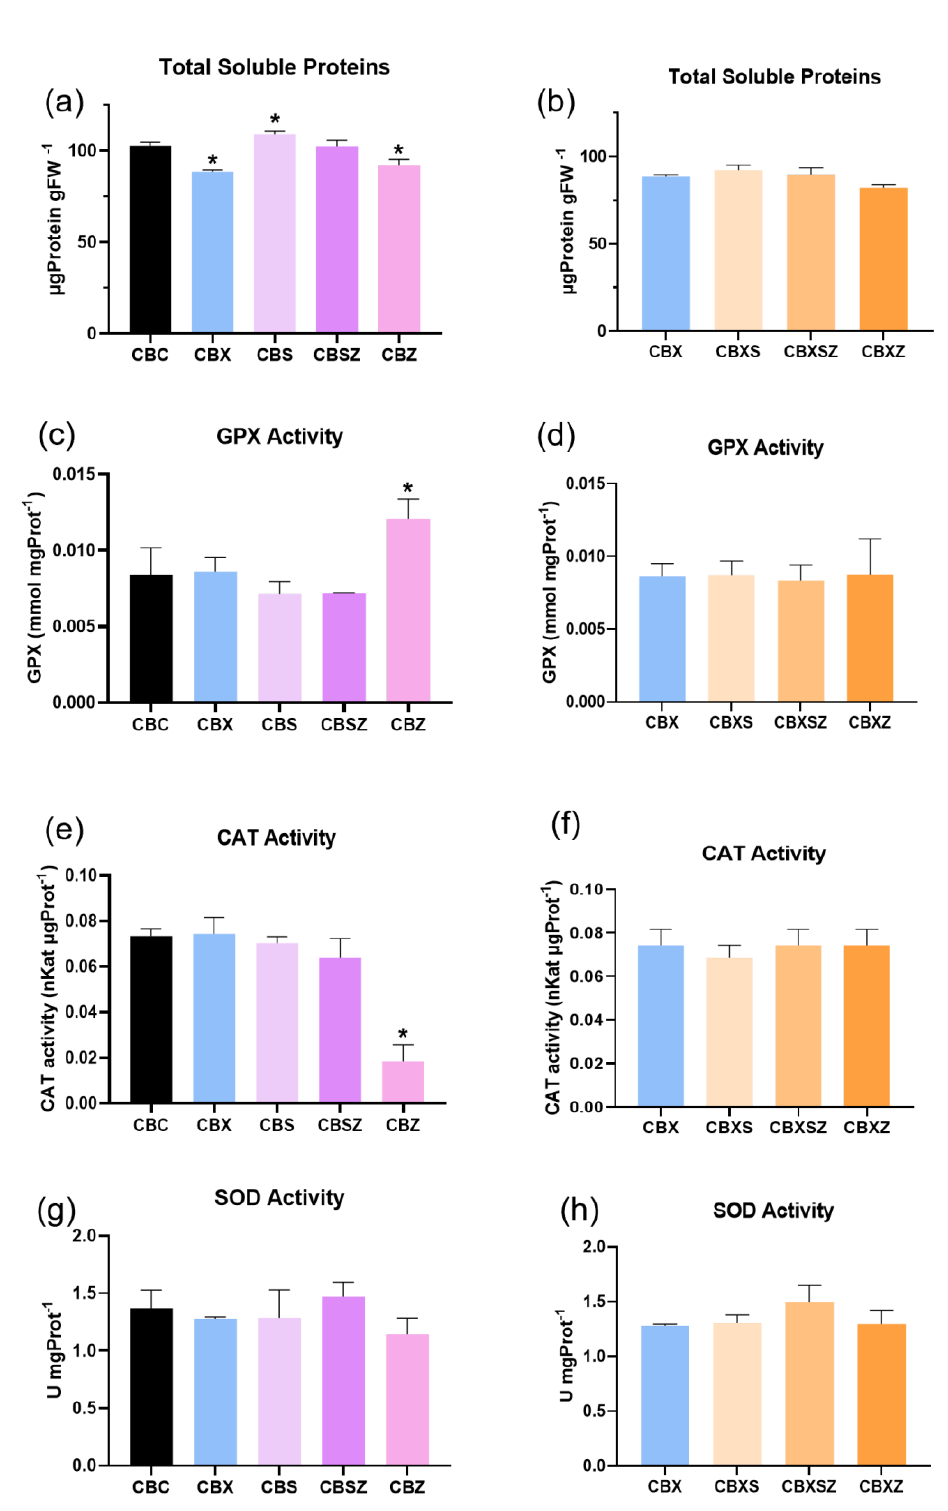
Figure 6. Effect of treatments (EO; EO-zein NPs; zein NPs) on tomato plants infected and uninfected with X. euvesicatoria 10 days after treatments. Total soluble protein content ( a , b ). GPX activity ( c , d ), CAT activity ( e , f ) and SOD activity ( g , h ). ( a , c , e , g ) represent the activities of uninfected/treated groups (CBS; CBSZ; CBZ) and the infected/untreated control (CBX) compared to the uninfected/untreated control (CBC). ( b , d , f , h ) epresent the activity levels of infected/treated groups (CBXS; CBXSZ; CBXZ) compared to the infected/untreated control (CBX). The values are presented as mean ± standard deviation (n = 3). Values marked with “*” are statistically different from the respective control according to the Dunnett comparison test ( p < 0.05).